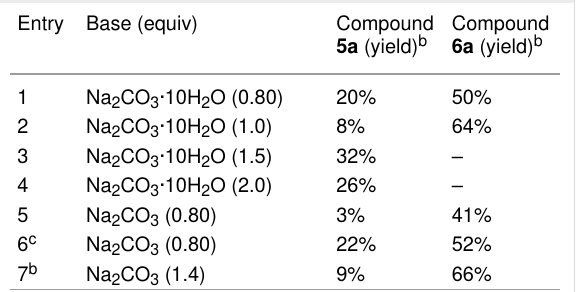
Table 1: Optimization of the cyclization step of 1,5-diacyl-5-hydroxypy- razoline 5b .